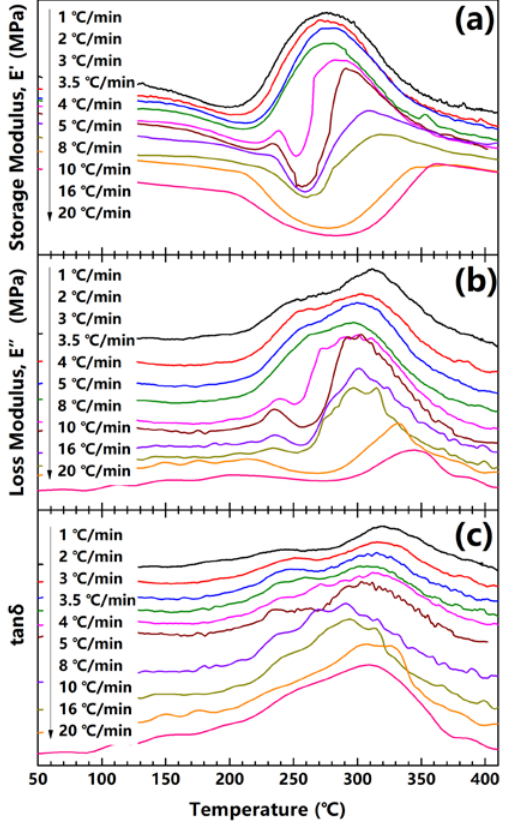
Figure 3. ( a ) Storage modulus; ( b ) loss modulus; and ( c ) tan δ of PAA fibers with temperatures under different heating rates.